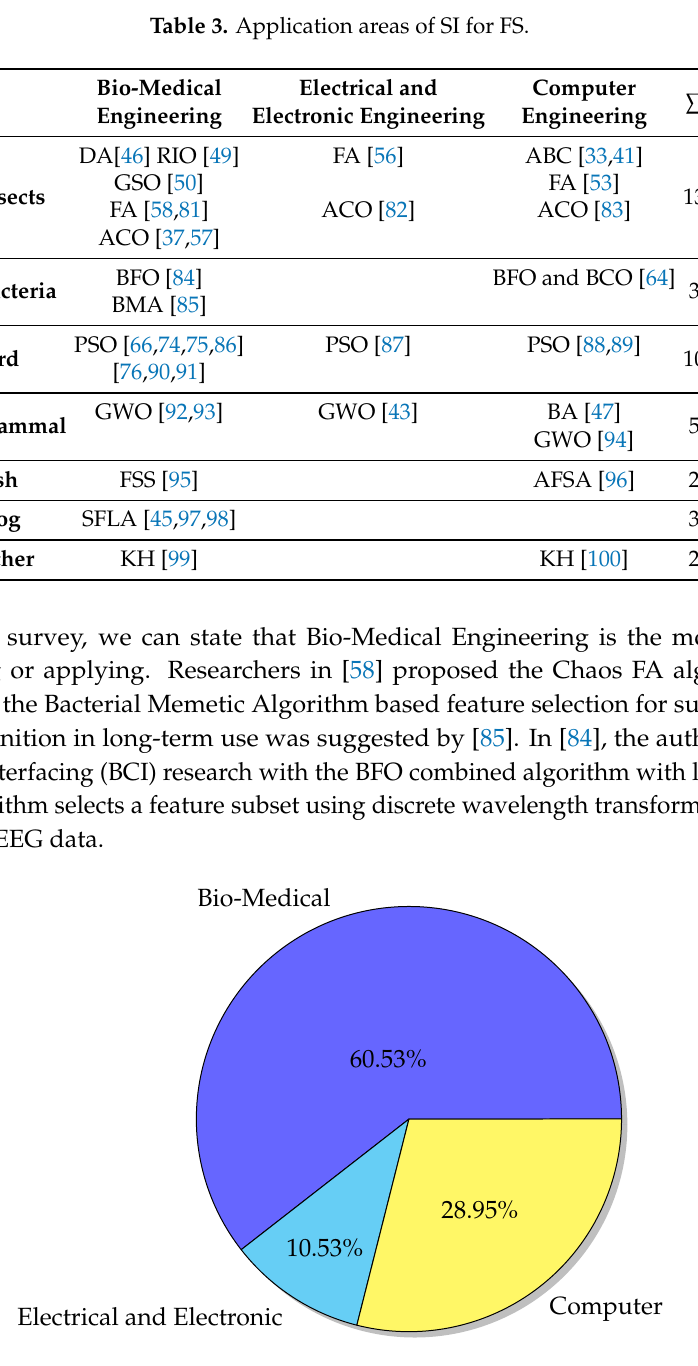
Figure 8. Analysis of applications in